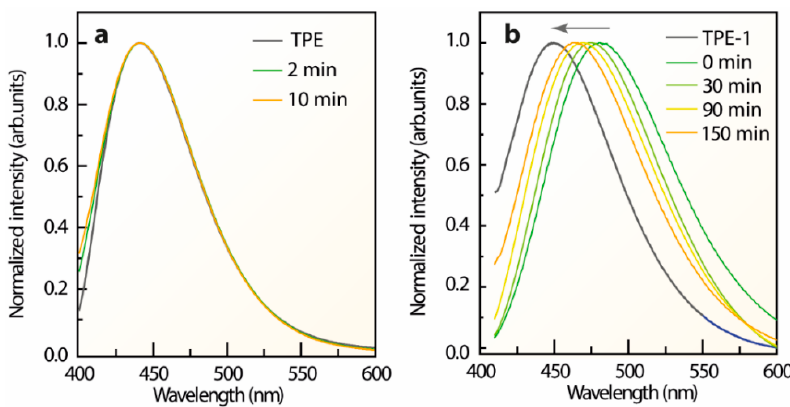
Figure 4. Emission spectra of ( a ) P-TPE and ( b ) P-TPE-1 solid states processed with 70 °C of heat treatments compared to that of the fully dried TPE and TPE-1 powders, respectively.